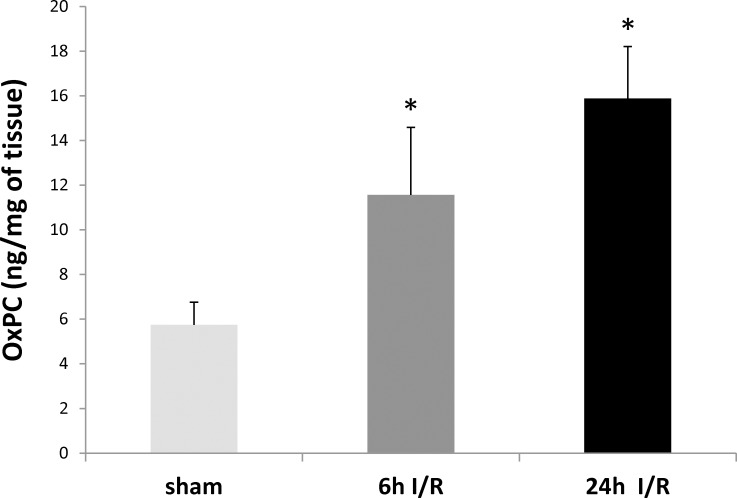
Total OxPC levels during renal I/R injury including fragmented and non-fragmented OxPC species measured in renal tissue in sham (light gray bar), 6h I/R (dark gray bar) and 24h I/R (black bar) groups.Values are means ± SEM (n = 4 in each group). * Significant difference compared to sham, P<0.05. Abbreviation: OxPC: Oxidized phosphatidylcholine.